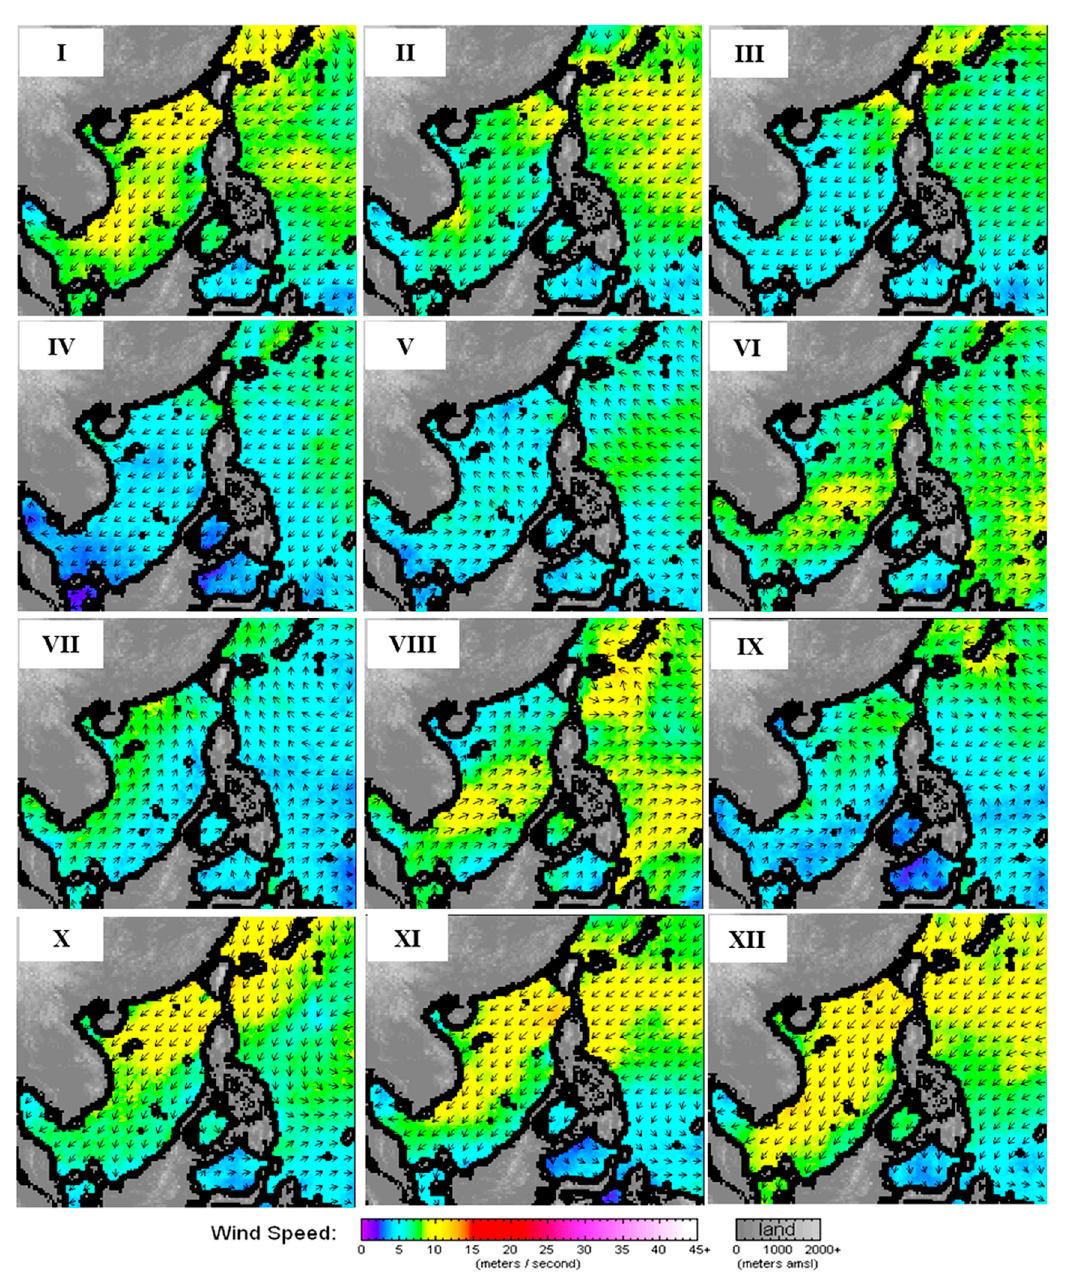
Figure 7. Typical average annual wind speed in 2004 of the Southeast Asian Sea, including Bien Dong, in relation to the Central Vietnam shoreline (Image source http://poet.jpl.nasa.gov).